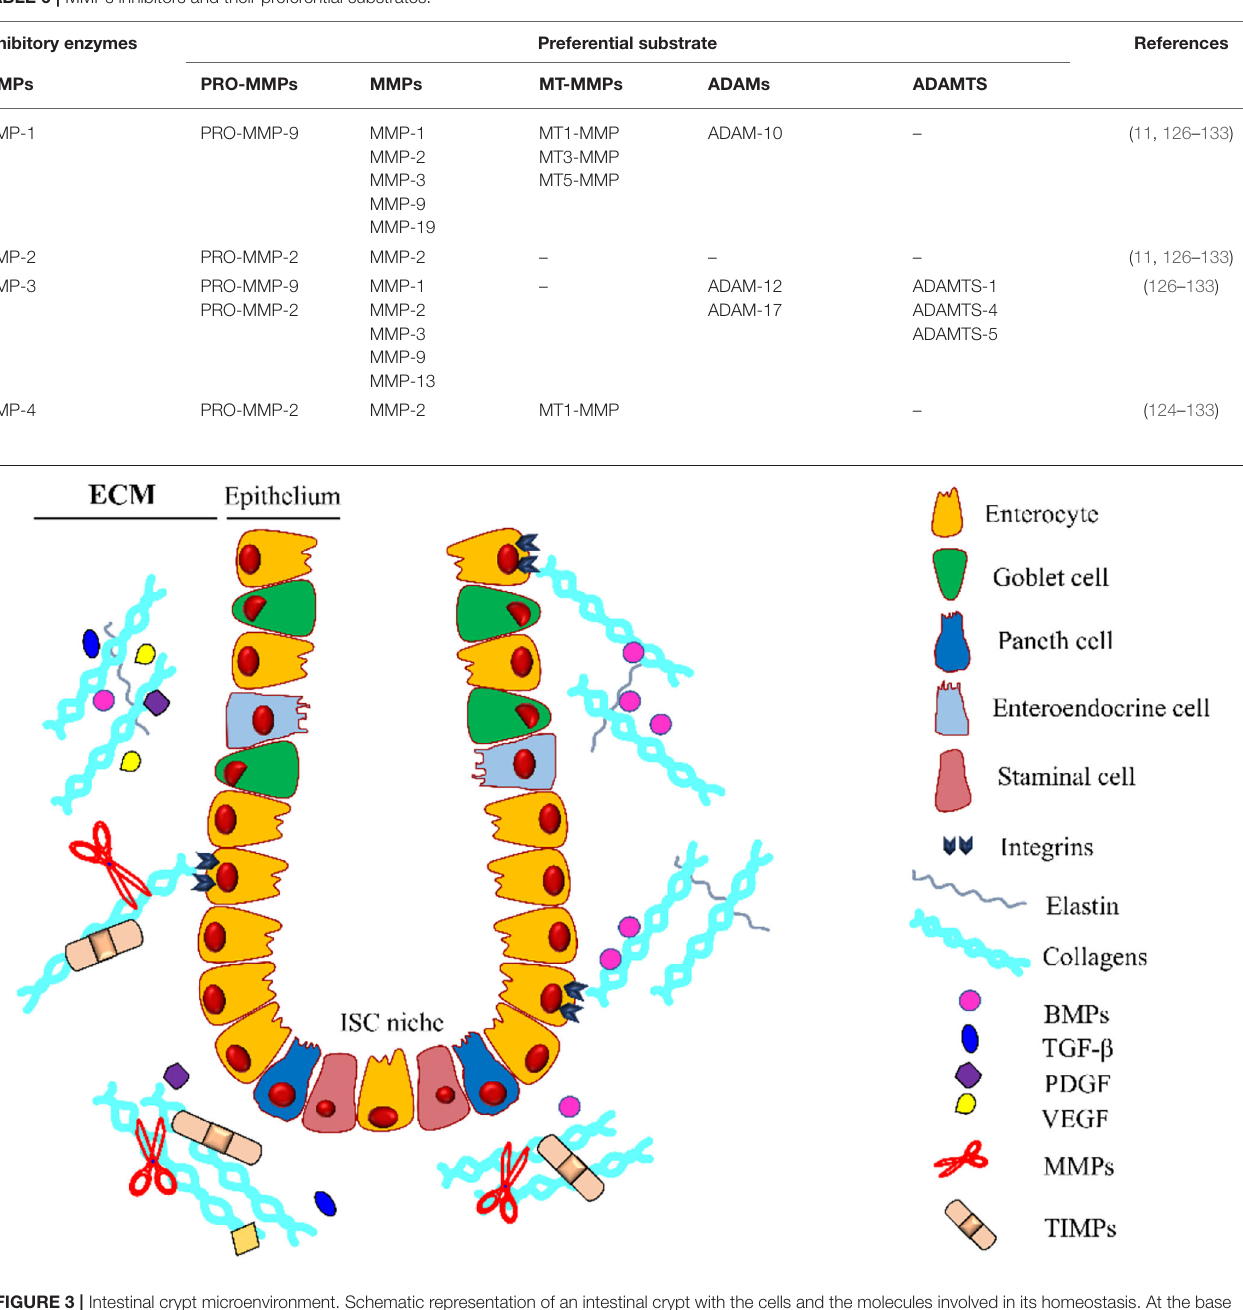
TABLE 6 | MMPs inhibitors and their preferential substrates.